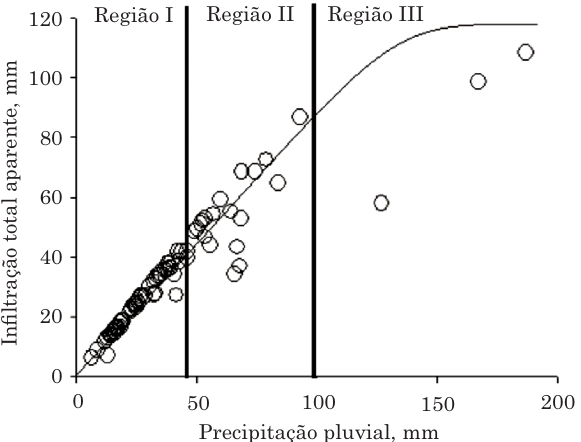
Figura 1. Relação entre a infiltração total aparente e a precipitação pluvial dos eventos